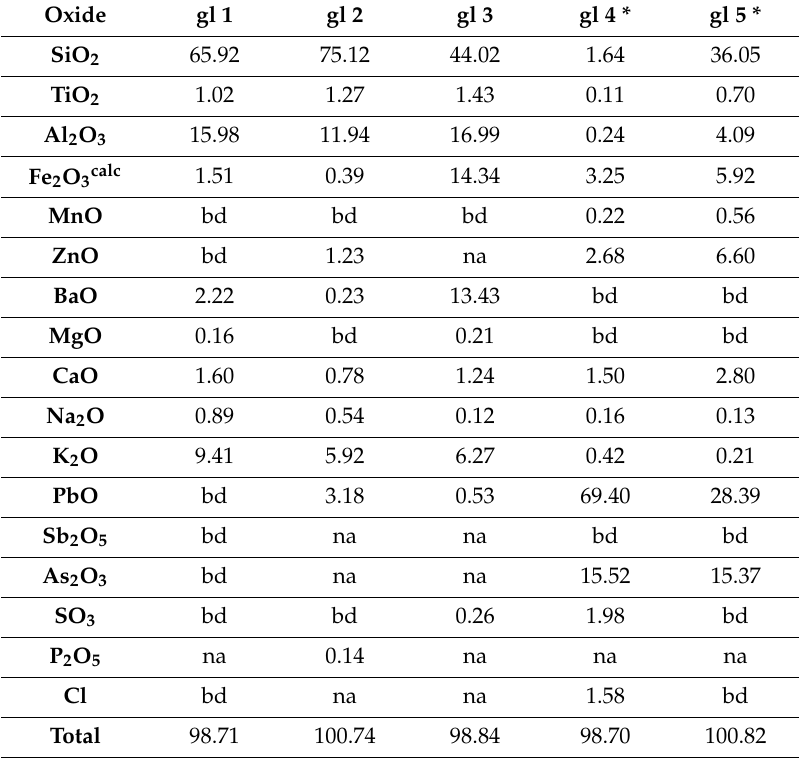
Table 5. Representative EPMA data of glass occurring at the contact zone of slag and refractory materials. Oxide gl 1 gl 2 gl 3 gl 4